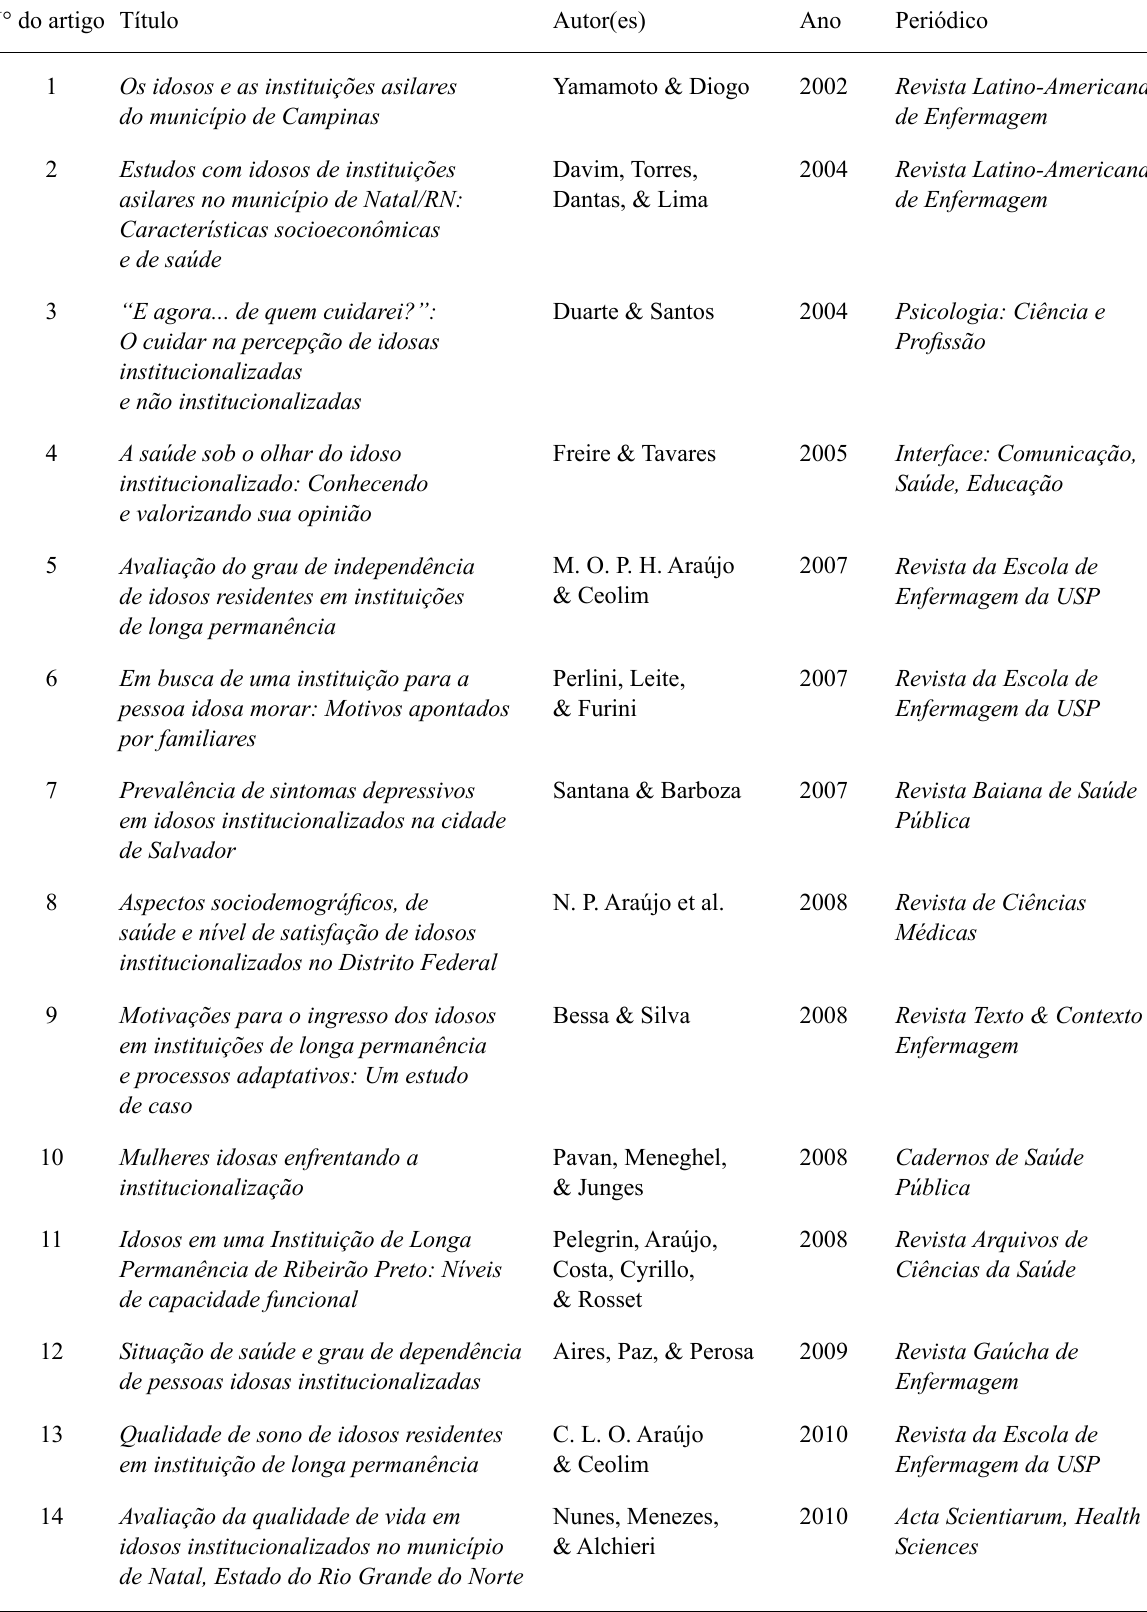
Identi fi cação dos Artigos Recuperados e Analisados em Termos dos Títulos, Autores, Ano da Publicação e